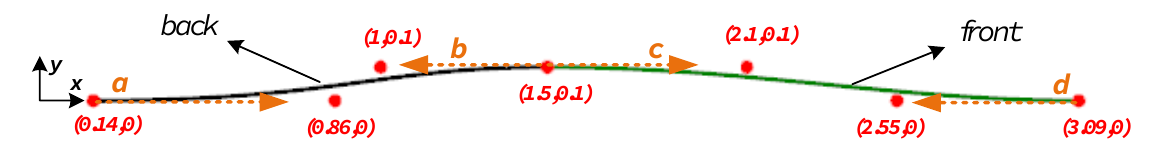
Figure 8. Schematic diagram of the width control feature curve of the flat-bottomed line.